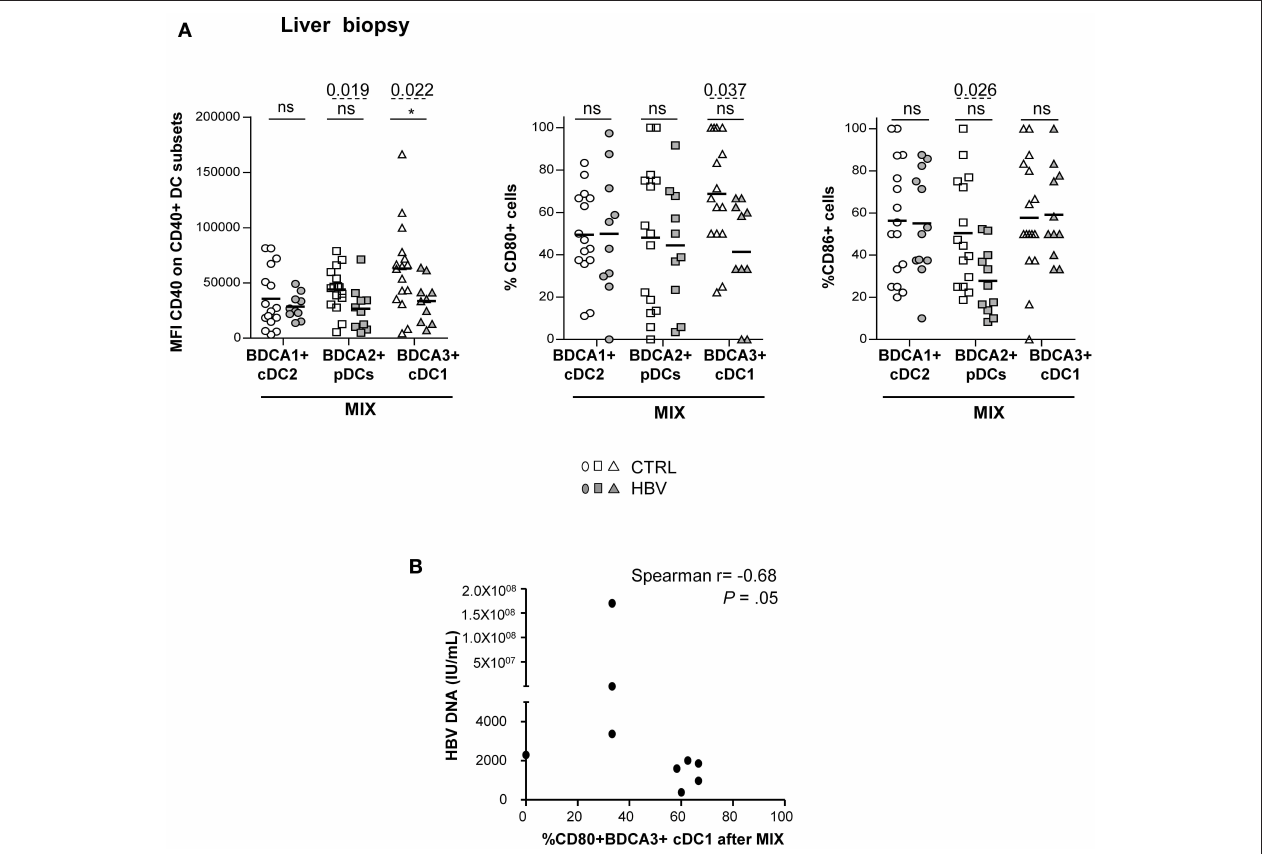
FIGURE 5 | Altered maturation of intrahepatic BDCA2 + pDCs and BDCA3 + cDC1 in chronic HBV patients after TLRs stimulation. LMNC suspensions from non-viral infected controls or HBV patients were stimulated for 22h with a mixture of TLRLs (MIX:polyI:C + R848 + CPG A ) and the expression of the maturation markers CD40, CD80, and CD86 was measured by flow cytometry. (A) Percentages or MFI of CD40, CD80, and CD86 molecules on cDC2, pDCs, and cDC1. Open symbols, CTRL ( n = 15–16); filled symbols, HBV ( n = 10–12). P -values were calculated using the 2-way-RM ANOVA test (straight line, * P ≤ 0.05) and Mann–Whitney test (dashed lines). Bar indicated mean. (B) Spearman correlations between CD80 on intrahepatic cDC1 from HBV patients after MIX stimulation with HBV DNA ( n =